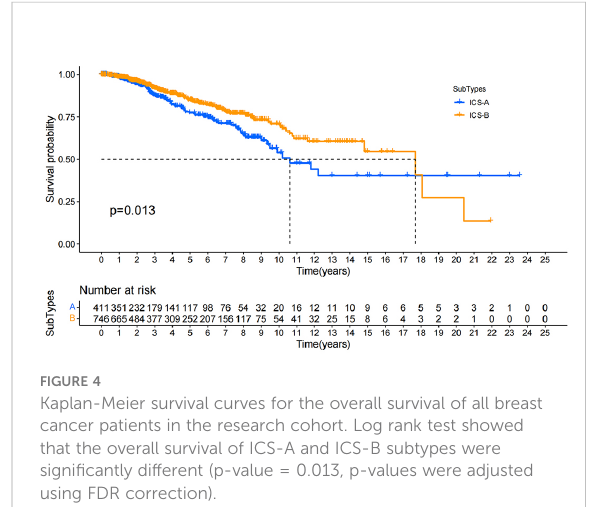
FIGURE 4 Kaplan-Meier survival curves for the overall survival of all breast cancer patients in the research cohort. Log rank test showed that the overall survival of ICS-A and ICS-B subtypes were signi fi cantly different (p-value = 0.013, p-values were adjusted using FDR